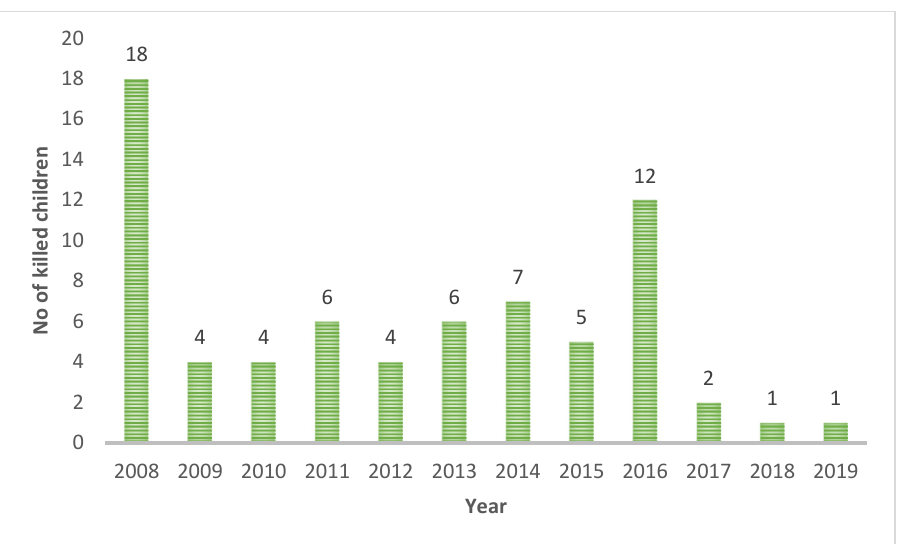
Figure 1. Annual number of children killed under the age of 15 in Scotland from 2008 to 2019 as a result of a land transport accident. Source:- Transport Scotland 2020 [2].